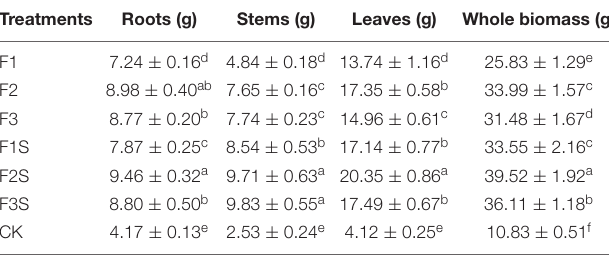
Values are presented as mean ± standard error from 10 replicates each treatment. Different letters indicate significant differences among treatments (Tukey’s test, P ≤